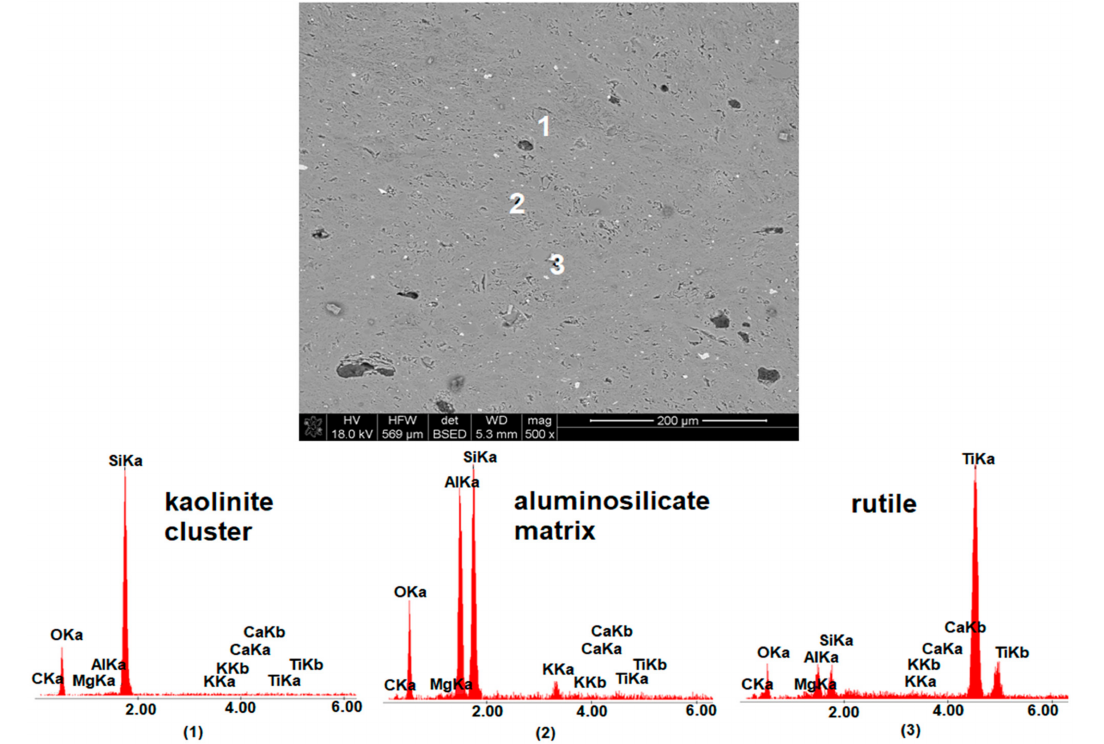
Figure 6. SEM-EDS image of M0 material fired at 1160 ◦ C.